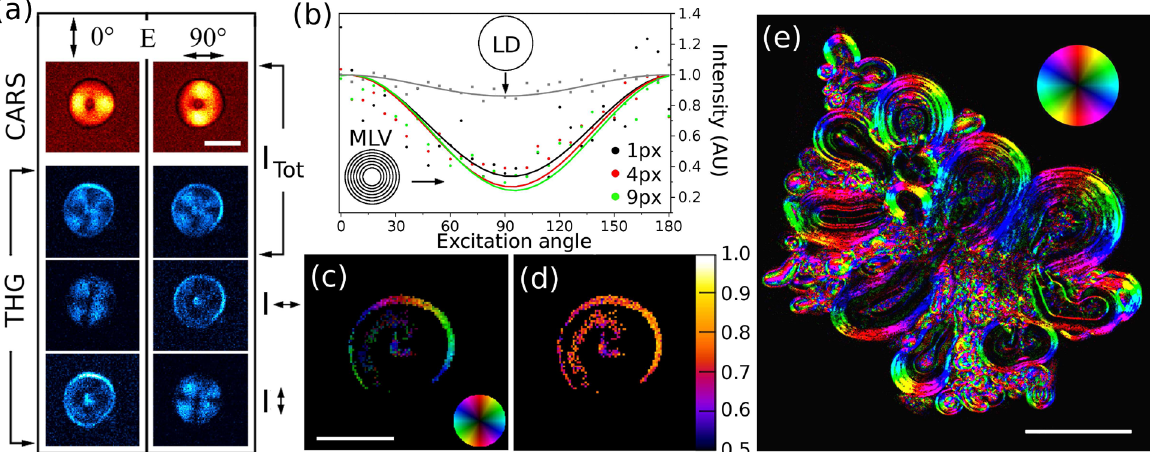
FIG. 5. P-NLOM imaging of ordered and amorphous lipid structures. (a) THG and CARS images of MLVs generated with two orthogonal polarizations (scale bar 15 (cid:2) m ). The maximum CARS signal is obtained with excitation fields polarized parallel to the moieties, i.e., to the MLV surface. Two types of THG signals are detected. The interface THG signal (analyzed in this study) is CH 2 maximized for an excitation field polarized parallel to the CC bonds (i.e., to the surface normal) and retains the excitation polarization. The bulk THG signal is due to MLV birefringence and is polarized perpendicular to the excitation. (See also movie S1 in Ref. [32].) (b) Comparison between the polarization dependence of THG from the surface of a lipid droplet (isotropic lipids) and a MLV (with approximately 10 3 bilayers), clearly showing the sensitivity of P-THG to molecular ordering. The MLV data analyses indicate that pixel averaging is not necessary to retrieve accurate estimates of the interface angle and modulation amplitude. (c)–(e) Extraction of order parameters. On a per-pixel basis, the fits can be used to construct maps of (c) the lipids orientation and (d) modulation amplitude based on the interface THG signal (scale bar 15 (cid:2) m ). The same fitting procedure can accurately extract physical parameters in more complex systems, such as the large lipid aggregate in (e) (scale bar 15 (cid:2) m ; see also movie S2 in Ref.